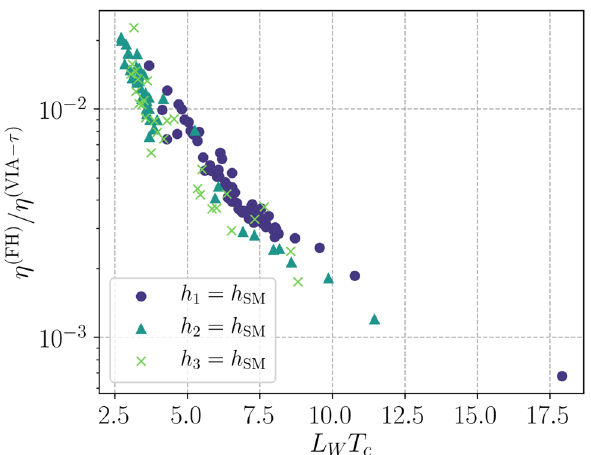
Fig. 8 Ratio of the BAU in the FH approach and in the VIA − τ approach as a function of L W T c for the allowed parameter points and h 1 being the SM-like Higgs boson h SM (violet dots), h 2 being SM-like (dark-green triangles), and h 3 = h SM (green crosses)